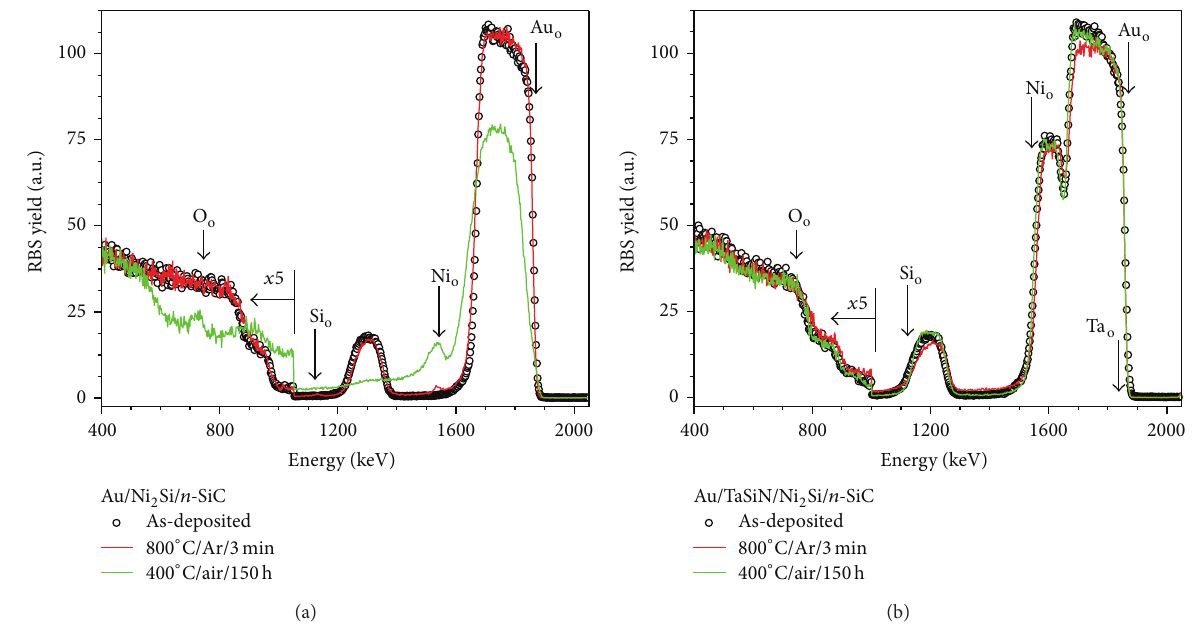
Figure 17: RBS spectra of the Au/Ni 2 Si/ n -SiC (a) and Au/Ta 35 Si 15 N 50 /Ni 2 Si/ n -SiC (b) ohmic contacts before and after heat treatments. By an arrow are marked the surface energies of the respective